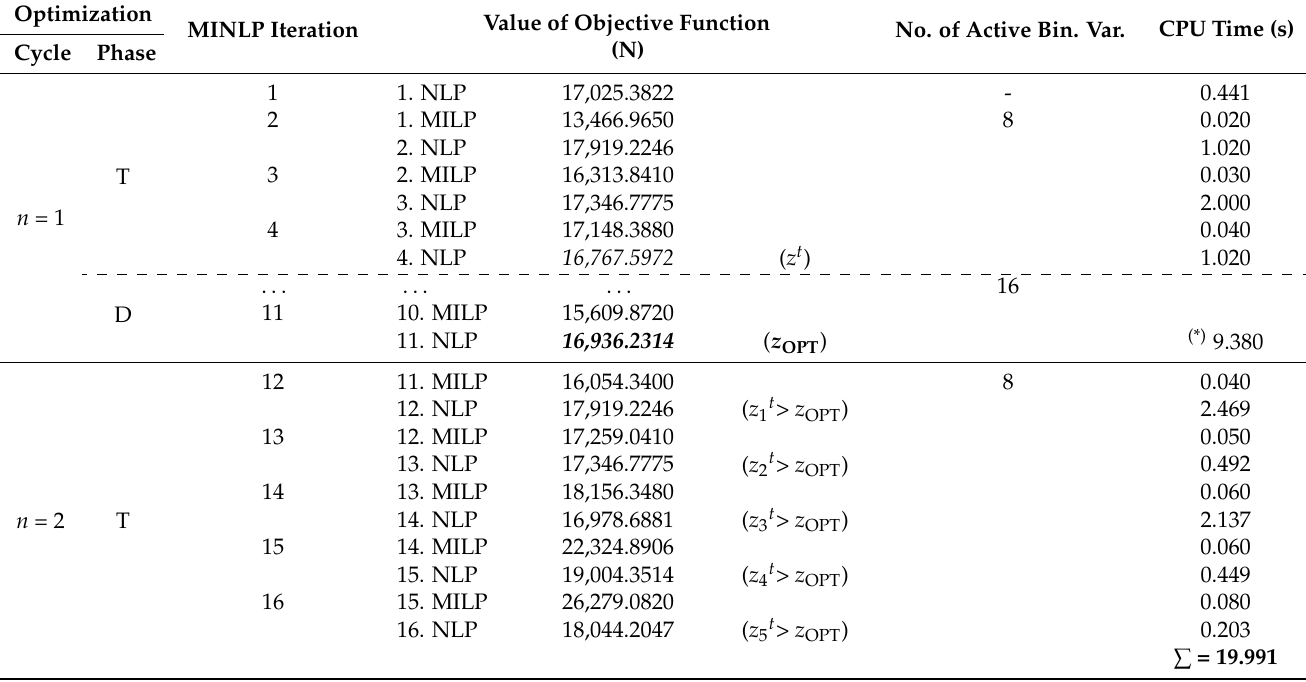
Table 3. Convergence of the Modified OA/ER algorithm and the MTP strategy, example TC10b (topology and shape optimization, without buckling